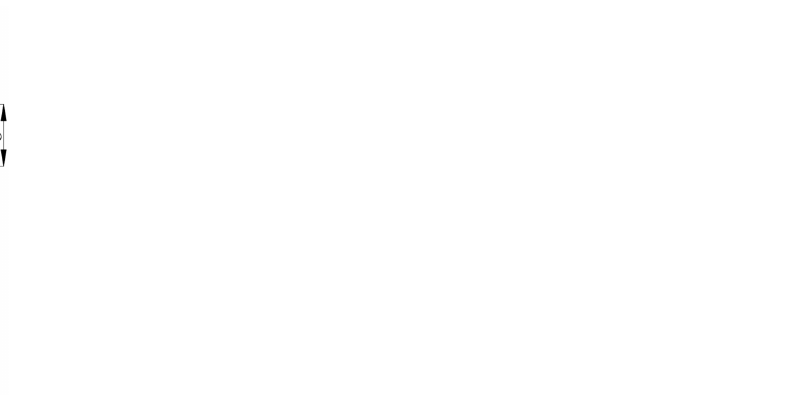
Figure 3. Method of measurement of thermal diffusion coefficient: 1—sample, 2 and 3—thermoelectric cells, 4—heating plate; b —known distance between thermoelectric cells, Q h —heat exchanged by conduction between plate and belt.